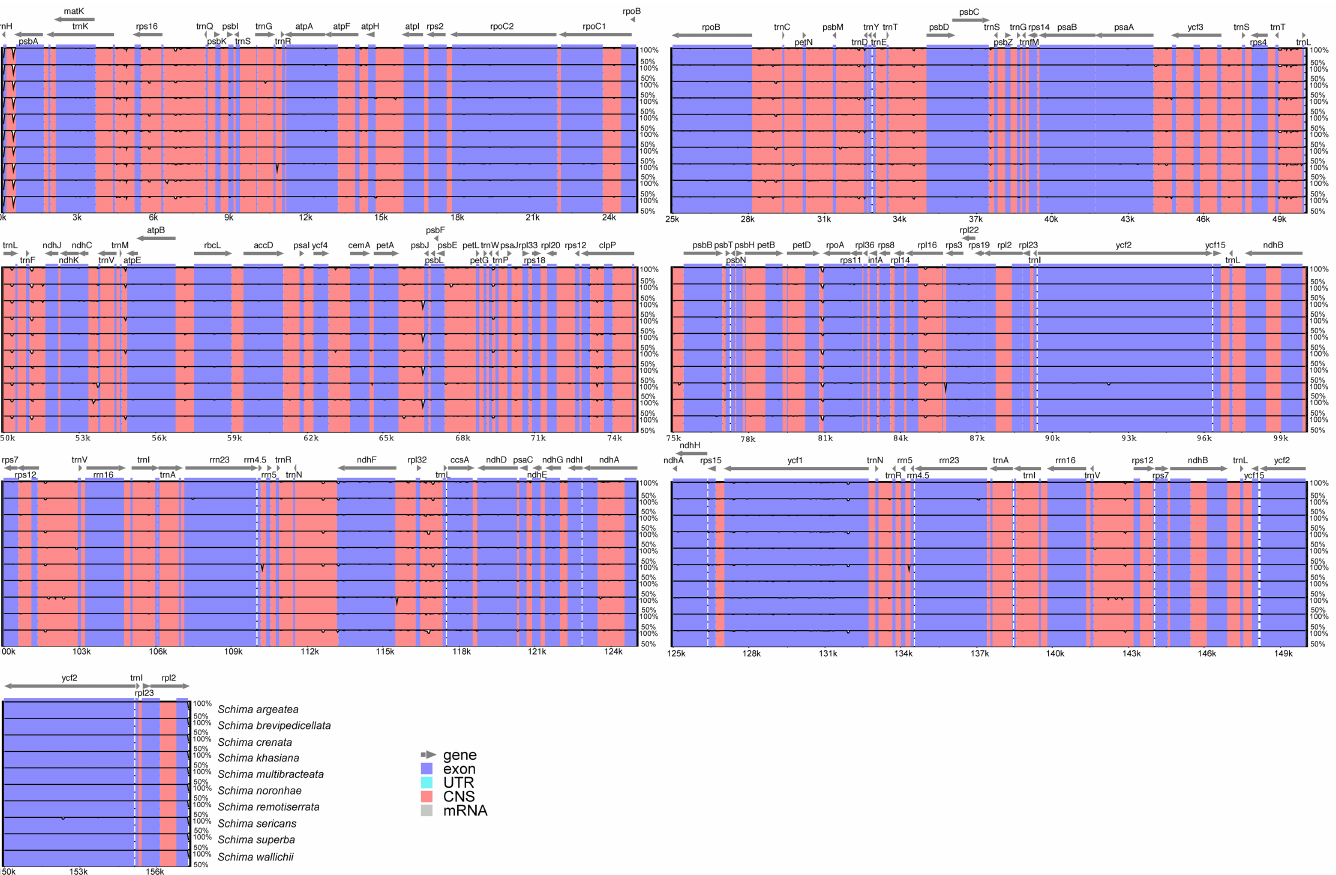
Fig 3. mVISTA percent identity plot comparison among the chloroplast genomes with S . sinensis as a reference.